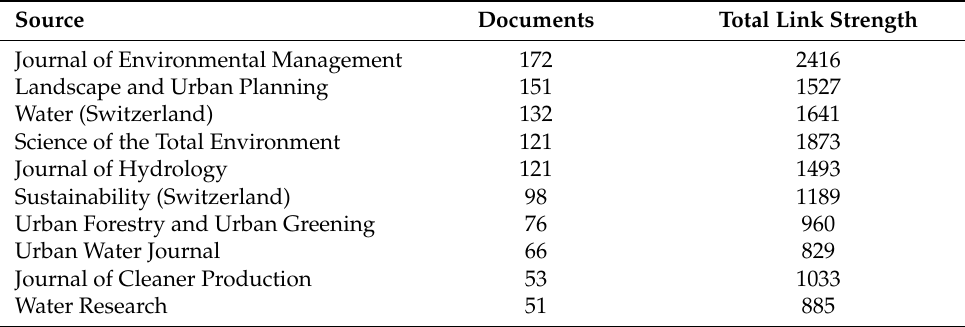
Table 3. Journals with the highest number of received citations.